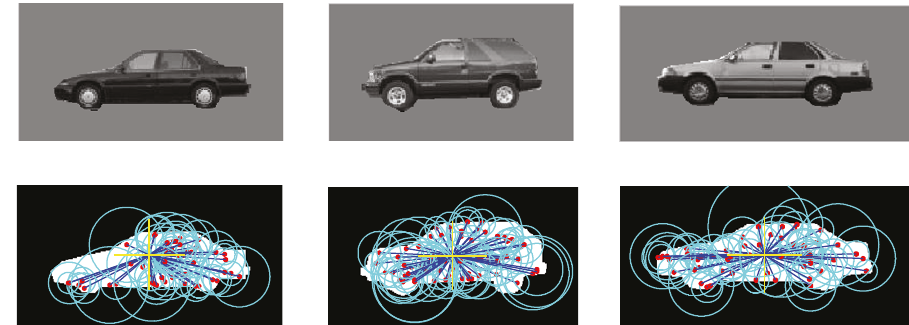
Figure 12: Foreground objects and detected local features.